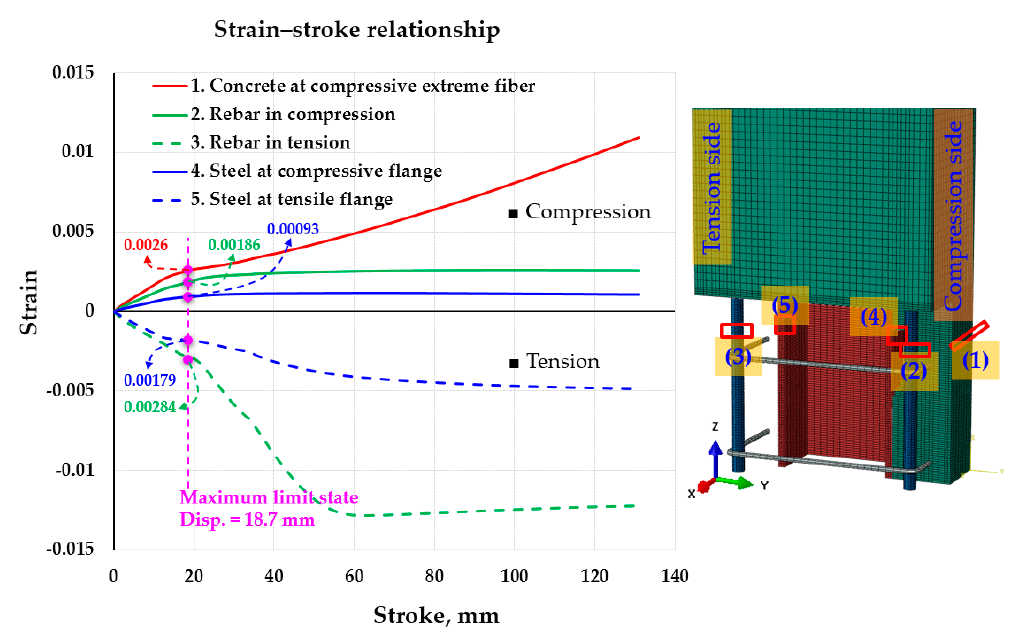
Figure 9. Strain vs. stroke curve for the components of the composite beam (concrete, rebar, H-steel).